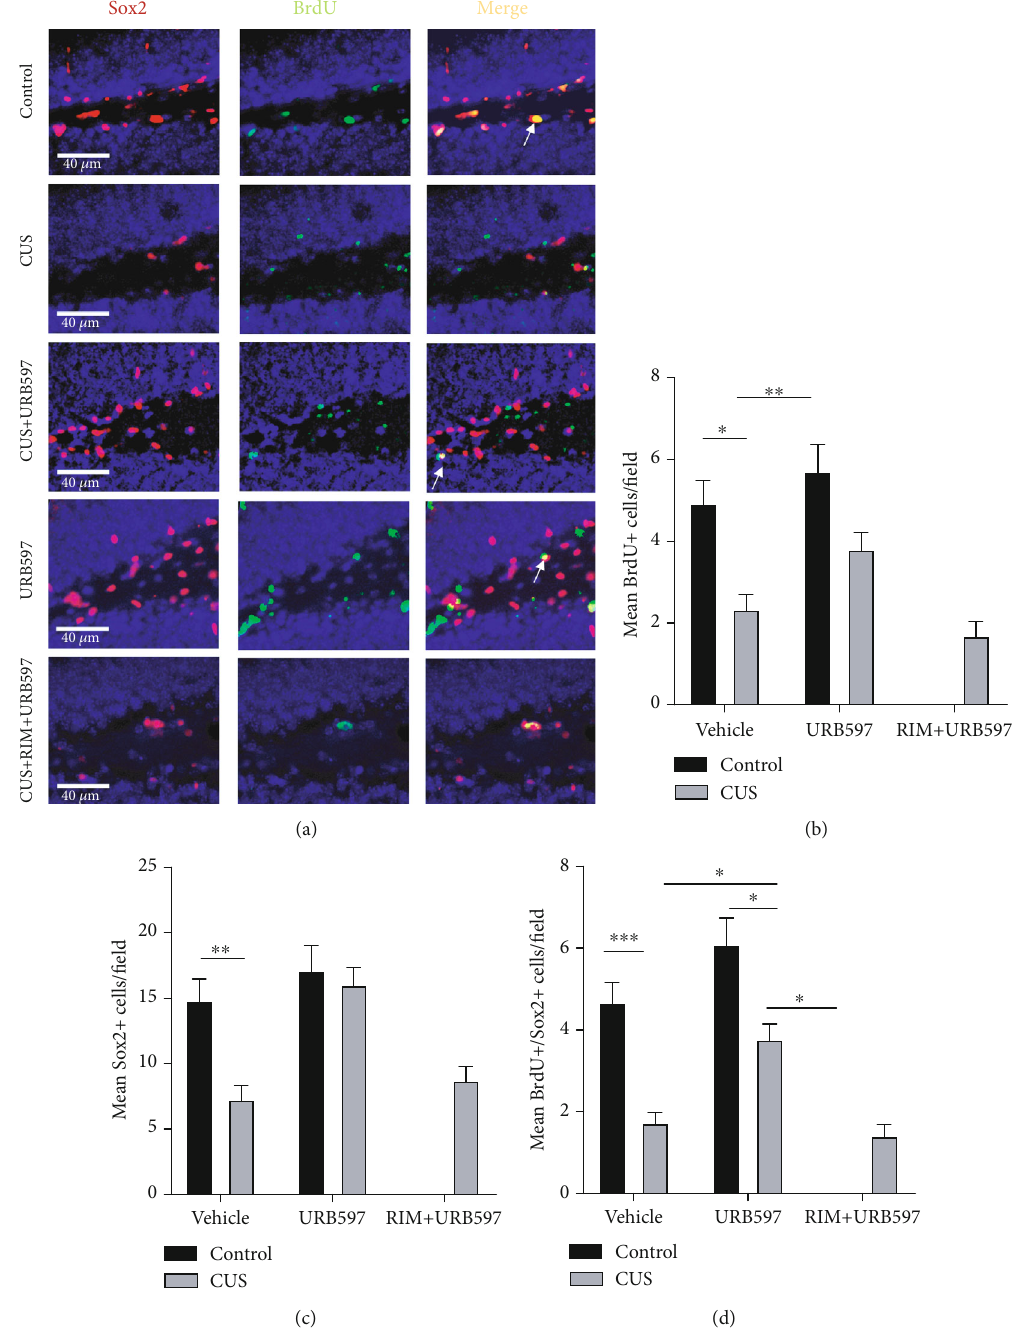
Figure 7: (a) Representative photomicrographs of the subgranular zone of the hippocampus where BrdU+/Sox2+ marking is observed. Marking for BrdU+ is seen in green, and the marking in red corresponds to Sox2+. The last panel of photomicrographs corresponds to the colocation of the two markings. Arrows indicate the positive cells analyzed. 40x bar = 40 μ m. (b) Average of Sox2-positive cells per fi eld of DG in the hippocampus. (c) Average of BrdU-positive cells per fi eld in the same region. (d) Mean number of merged cells per fi eld. Columns represent the average of the cells counted in each field ± SEM , n = 6 /group; ∗ p ≤ 0 : 05 ; ∗∗ p ≤ 0 : 01 ; ∗∗∗ p ≤ 0 : 001 . Two-way ANOVA post hoc Holm-Sidak ’